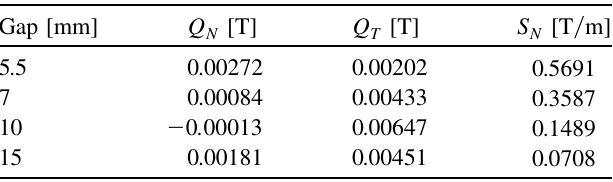
TABLE VIII. Summary of integrated multipolar components at minimum gap of 5.5 mm.